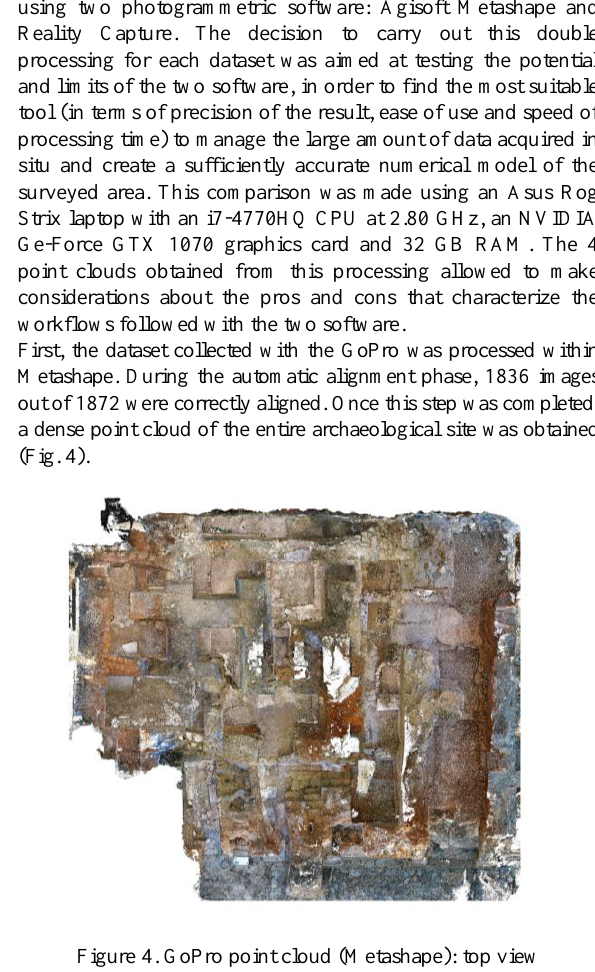
Figure 4. GoPro point cloud (Metashape): top